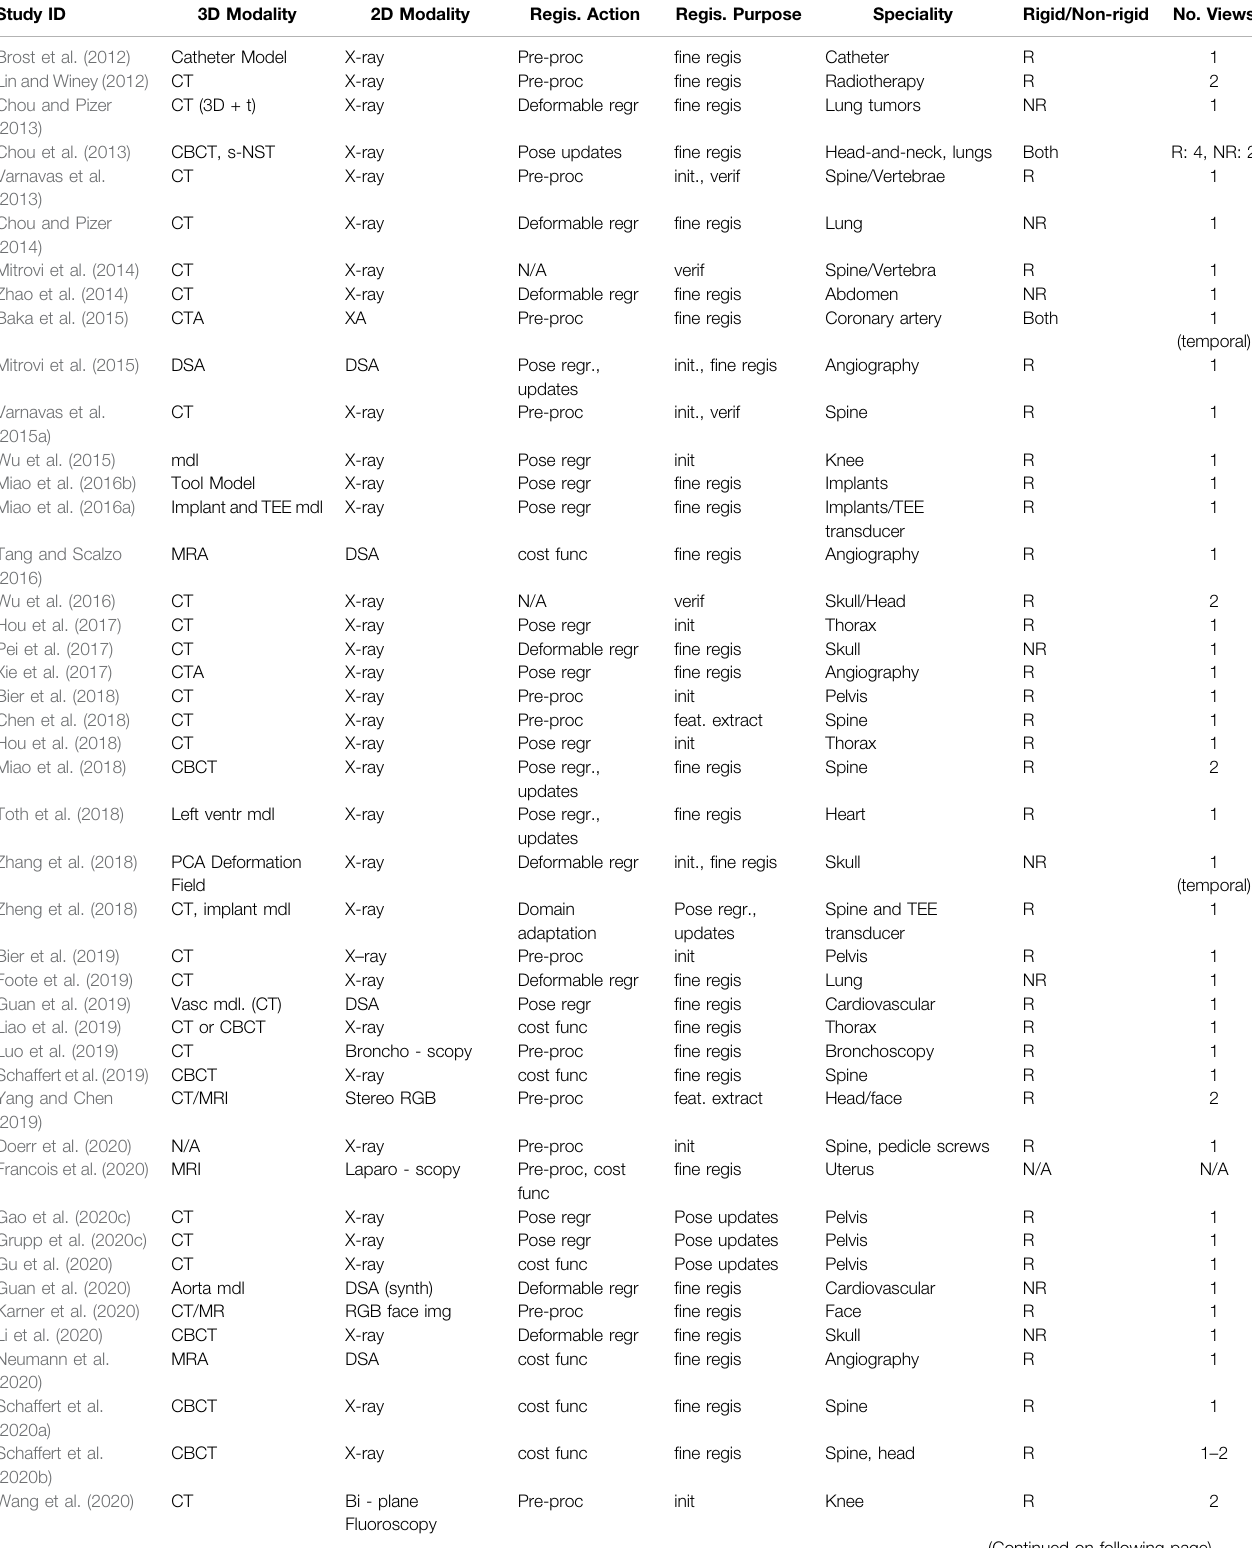
TABLE 1 | Parameters de fi ning theregistrationproblemsdescribedin thestudies included forreview. Registration purpose refers tothe registration stagebeing addressed, such as initialization (init.), precise retrieval of geometric parameters ( fi ne regis.), or